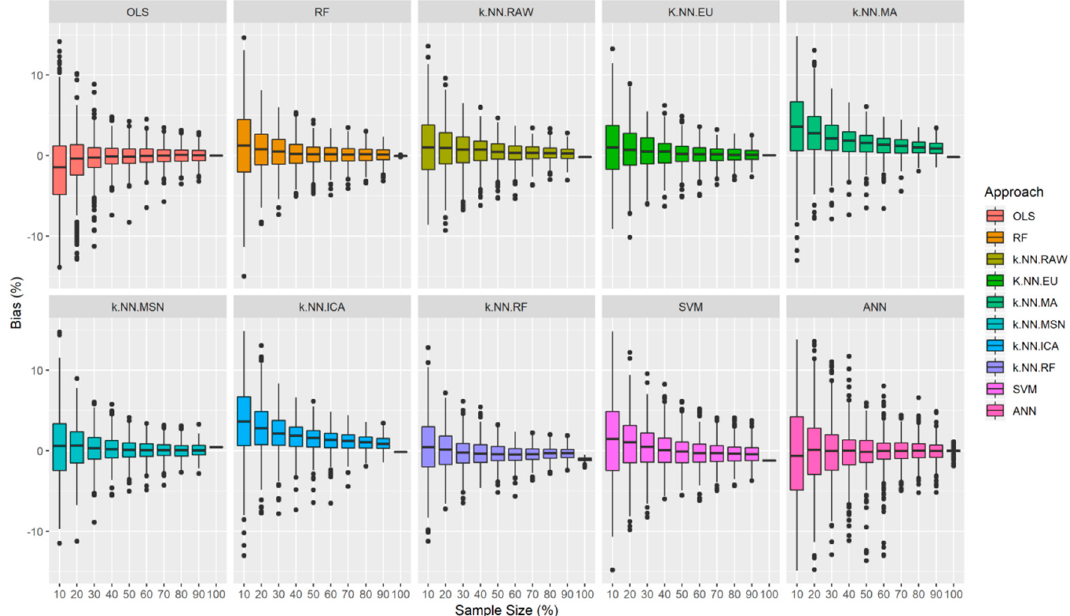
Figure 5. Modeling methods’ performance in terms of bias derived from the 500 bootstrapping simulations for each sample size.